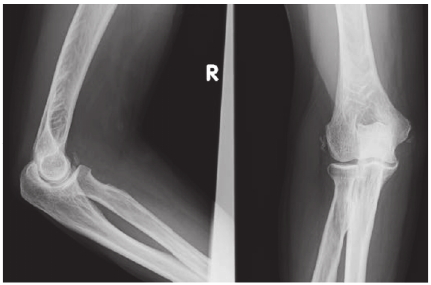
Figure 7: Eight weeks after the trauma, radiographs revealed mild calcification around the anterior articular capsule, medial collateral ligament, and lateral collateral